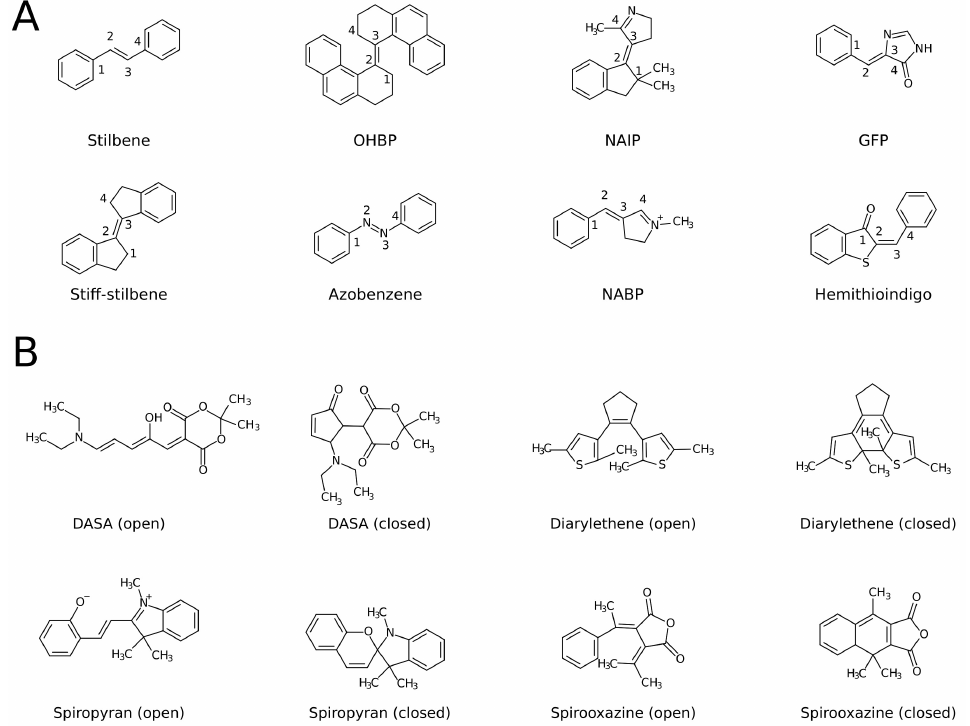
Figure 1. Structures of molecules used in the work. ( A ) Optical switches based on cis / trans isomerism ( E/Z -switches). OHBP, trans1,1’,2,2’,3,3’,4,4’octahydro4,4’biphenanthrylidene (an over- crowded alkene); NAIP, Nalkylated indanylidene pyrroline (retinal analog); GFP, green fluorescent protein fluorophore; NABP, Nalkylated benzylidene pyrroline (retinal analog). ( B ) Optical switches based on ring open/closed reaction ( O/C -switches). DASA, donor-acceptor Stenhause adducts. For the sake of simplicity merocyanine and fulgide are named as open forms of spyropyran and spyrooxazine,